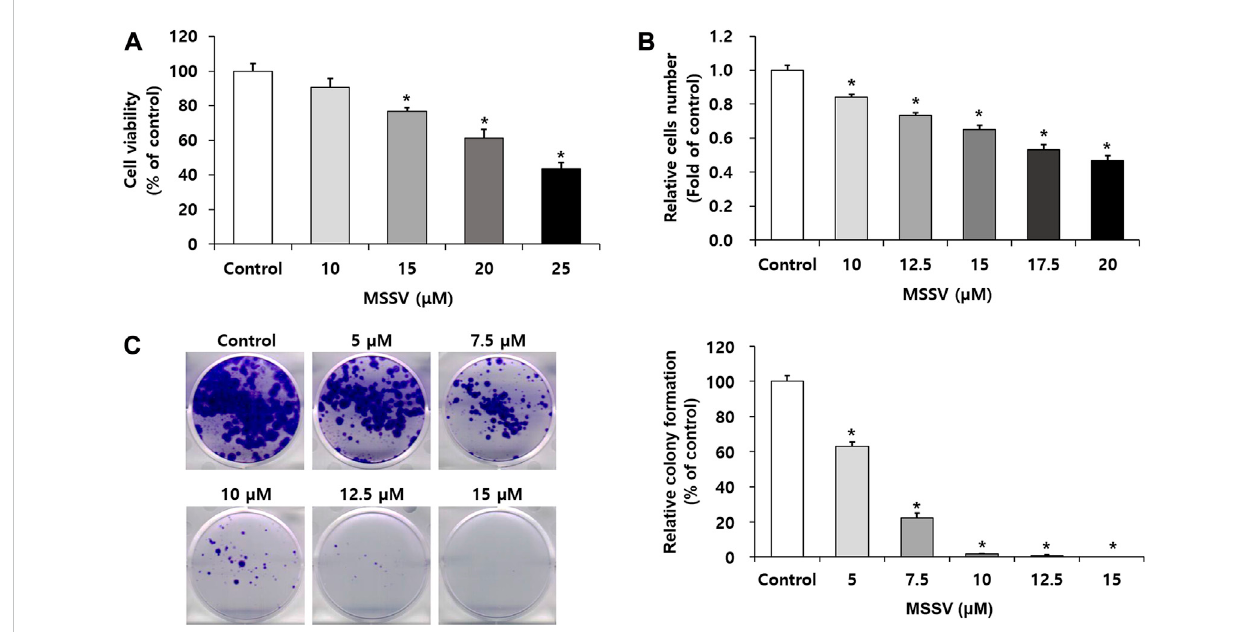
FIGURE 2 MSSV inhibitsthe proliferative capacity against CRC cells (A) HCT116 cells were incubatedin the presence or absence of MSSV for 24 h. Cell viability was estimated by an MTT assay. (B) A cell counting assay was performed to determine the anti-proliferative activity. Trypan blue staining method was applied for the estimationof cell proliferation. (C) The inhibitory effects of MSSV on thecolony formation of HCT116 cell. HCT116 cells were incubatedin the presence or absence of MSSV on a 6-well plate for 12 days, followed by colony formation. Data are presented as mean ± SD and the * (asterisk) indicates a statistically signi fi cant difference. A p -value of < 0.05 was considered statistically signi fi